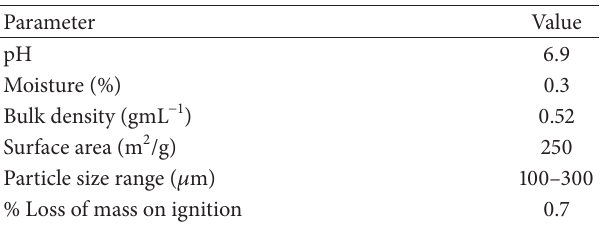
Table 1: Characteristics of the activated carbon derived from maize tassel.